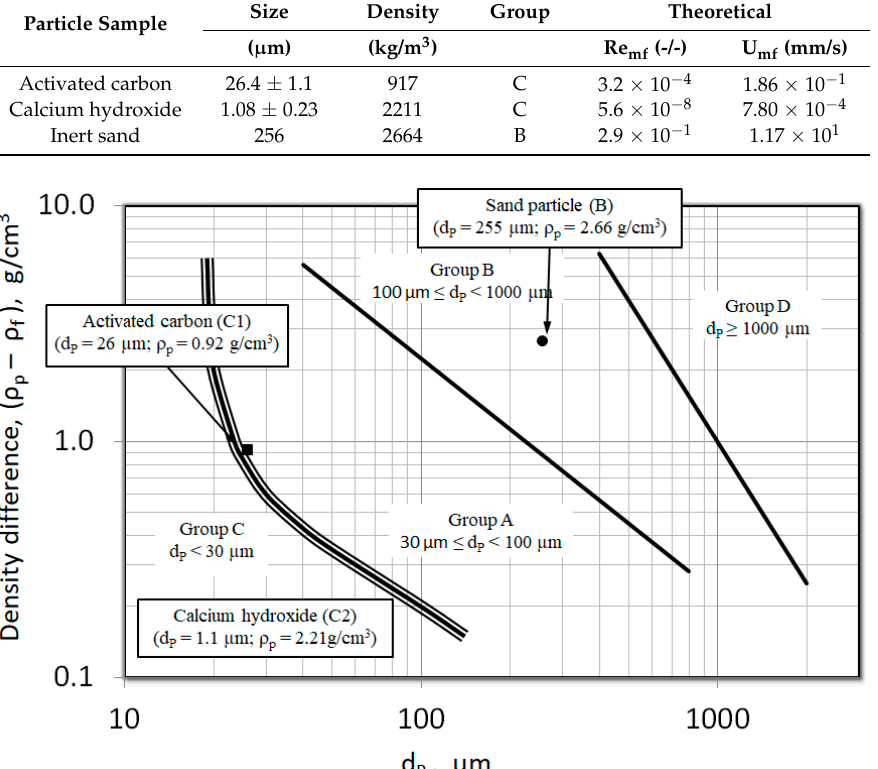
Table 1. Main characteristics of the particle samples used.